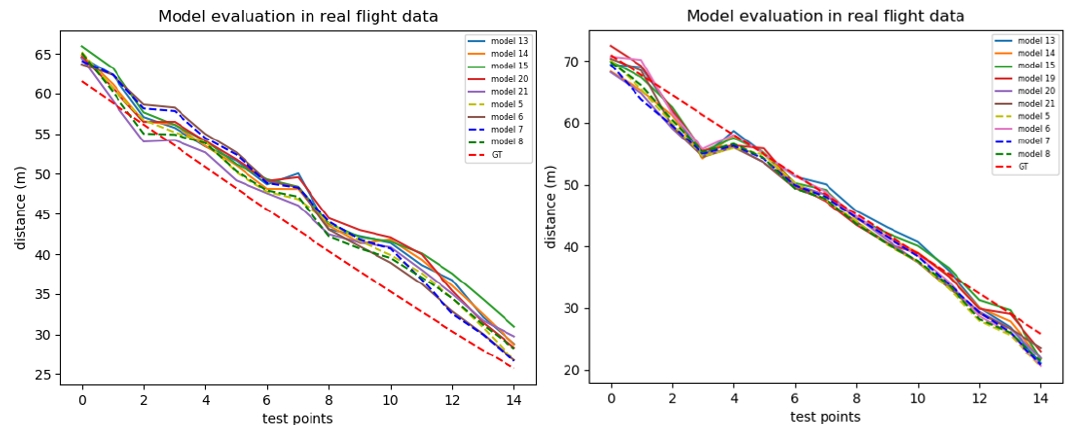
Figure 9. Evaluation results of the models with different amounts of fully connected (FC) layers.